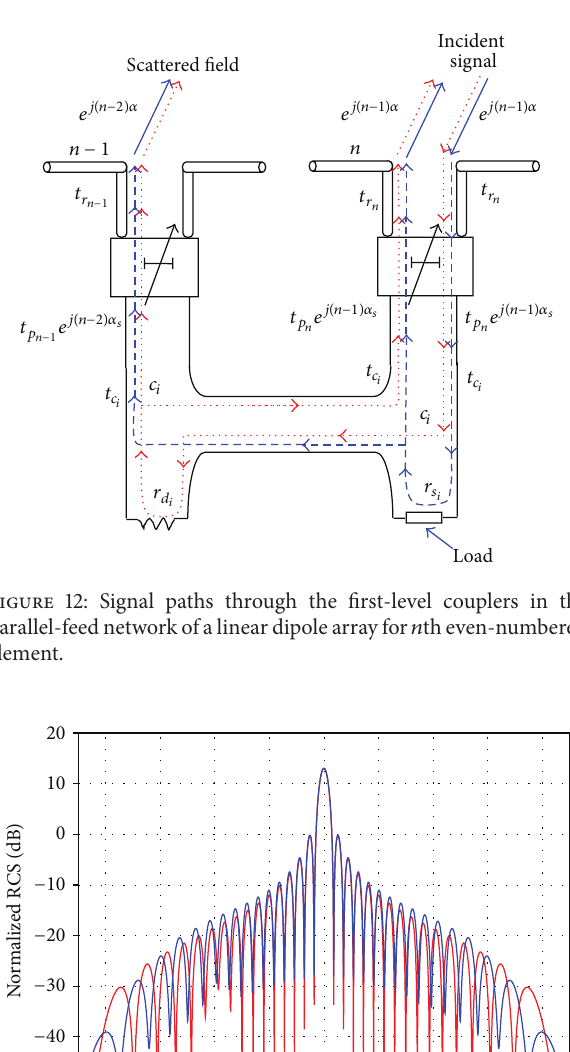
Figure 11: Signal paths through the first-level couplers in the parallel-feed network of a linear dipole array for 𝑛 th odd-numbered element.